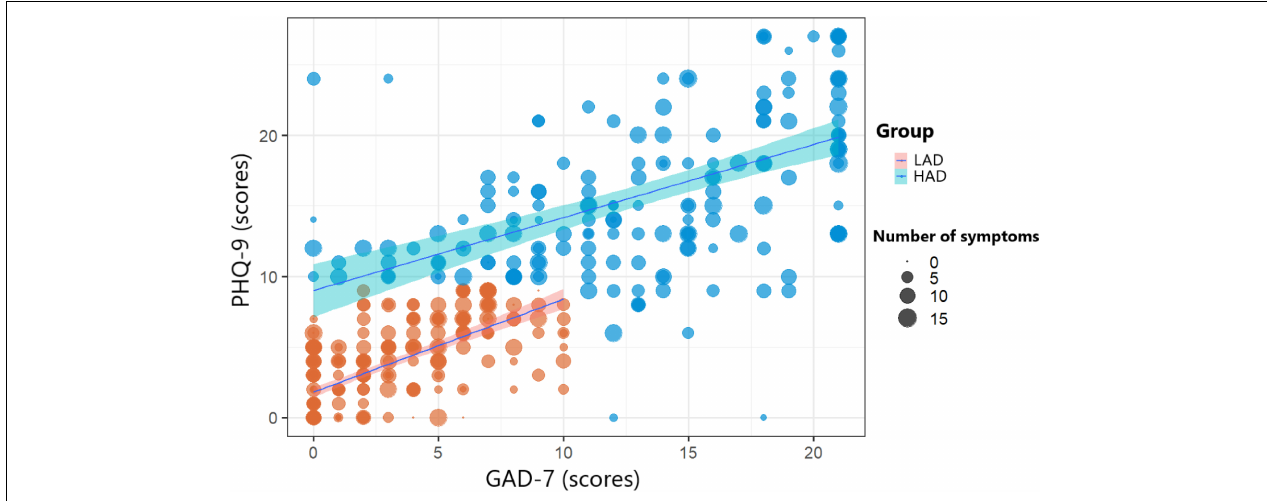
FIGURE 1 | Correlation between General Anxiety Disorder-7 (GAD) and Patient Health Questionnaire-9 (PHQ) scores according to anxiety and depression status and number of